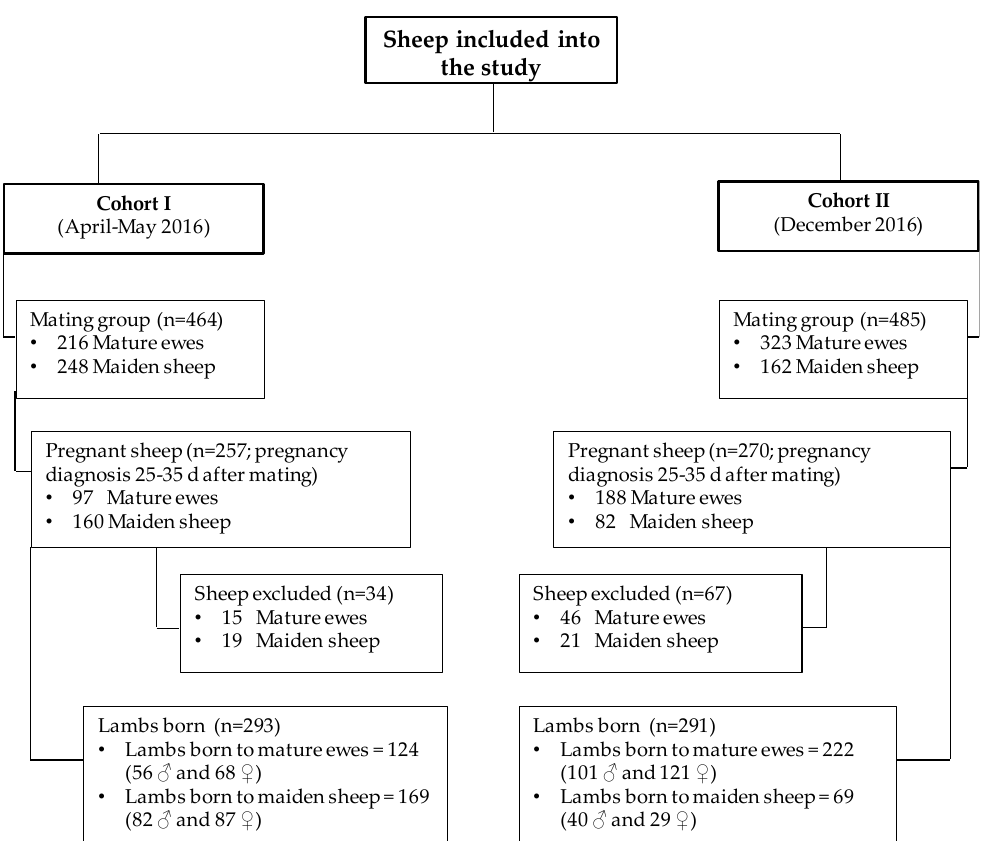
Figure 1. Scheme illustrating sheep inclusion in the different cohorts to follow sheep pregnancy, lambing, the postpartum period, and the neonatal life of the studied individuals at a commercial, high-yielding Lacaune dairy farm.